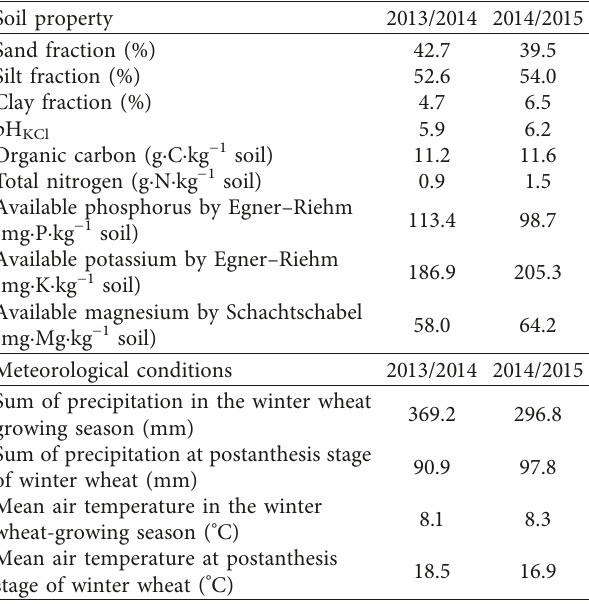
Table 1: Environmental conditions at the experimental